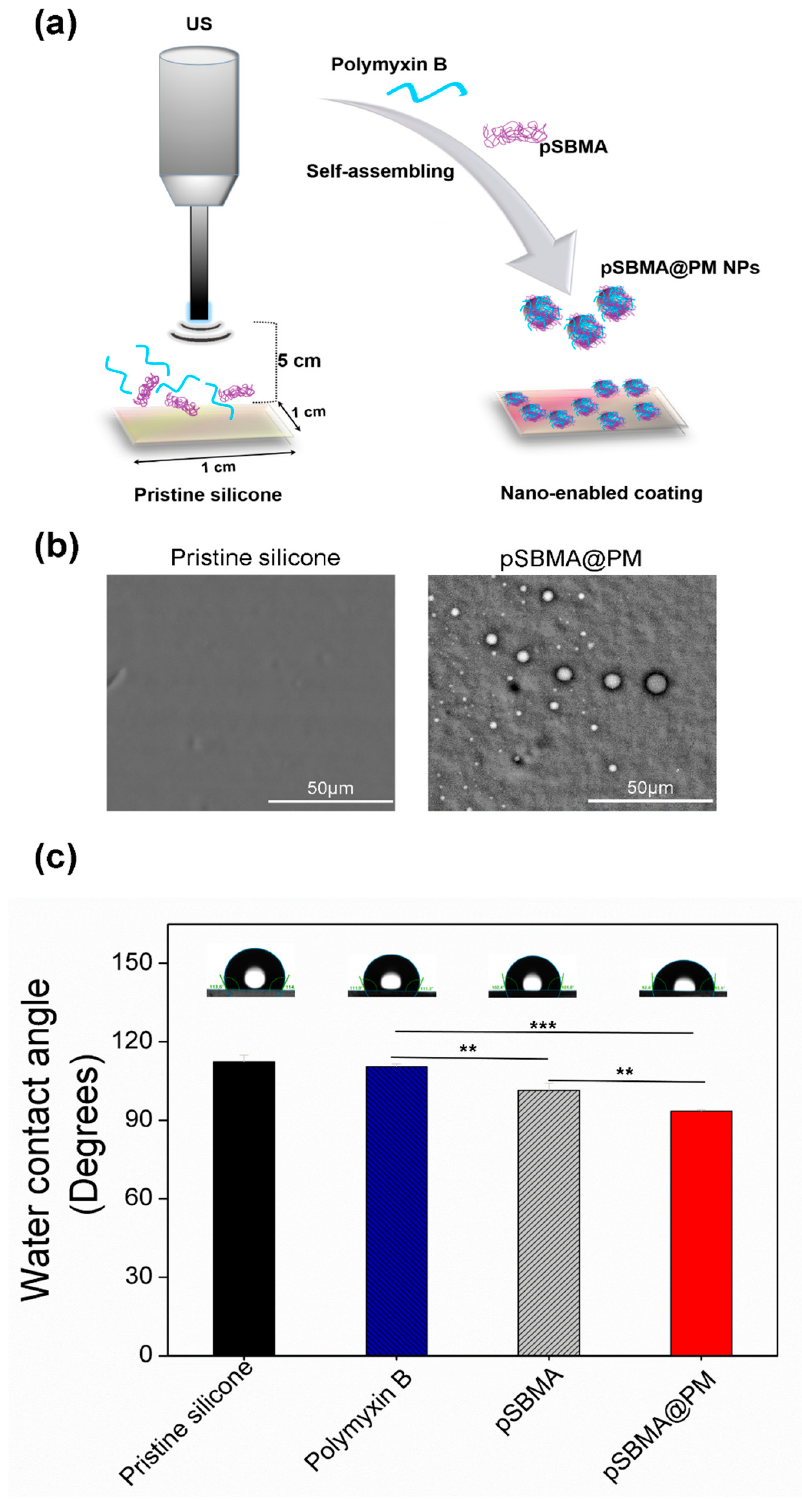
Figure 1 . ( a ) Schematic representation of US-assisted pSBMA@PM NPs formulation and their deposition onto silicone surface. Surface characterization of sonochemically coated with pSBMA and Polymyxin B silicone materials: ( b ) SEM images of pristine and pSBMA@PM coated silicone catheter and ( c ) Water contact angles measurements of the developed nanocoatings. All data are mean values of three independent experiments. Stars represent the statistical differences between the different groups of samples, ** p< 0.01; ***p< 0.001.